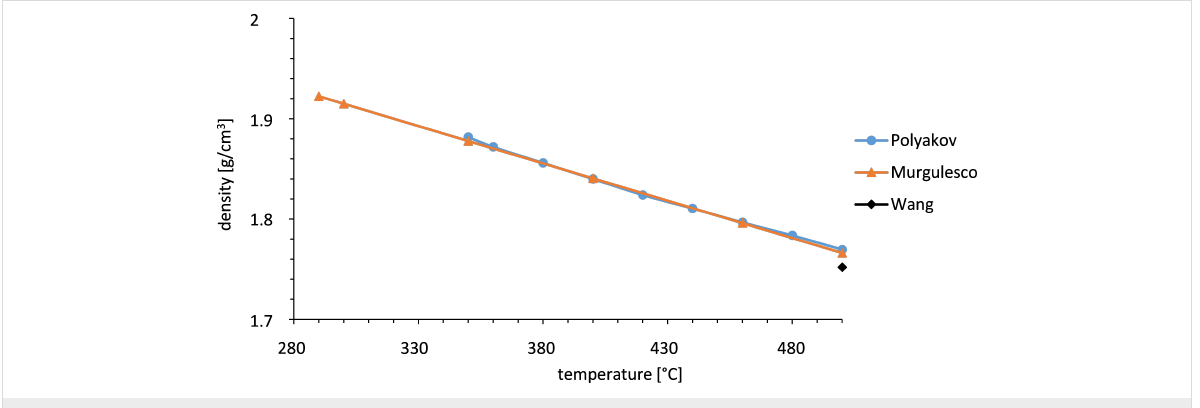
Figure 4: Density of Solar Salt in the liquid state [9,16,17].